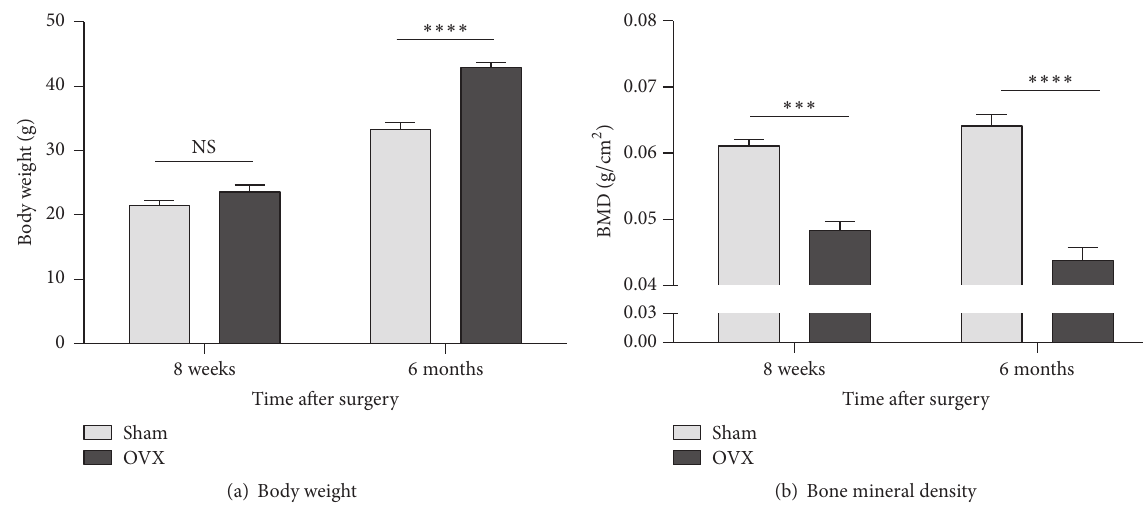
Figure 1: Effect of ovariectomy on body weight and bone mineral density. Body weights are higher in ovariectomized (OVX) mice than in sham-operated (sham) animals at 6 months, but not at 8 weeks, after surgery (a). Vertebral bone mineral density is lower, at both 8 weeks and 6 months after surgery, in OVX mice than in sham mice (b). Data are expressed as means ± standard error of the mean. NS: not significant; ∗∗∗ 𝑃 < 0.001 ; ∗∗∗∗ 𝑃 < 0.0001 ; and OVX versus sham, two-way repeated measures analysis of variance (factors = group × time) followed by Tukey’s test for multiple